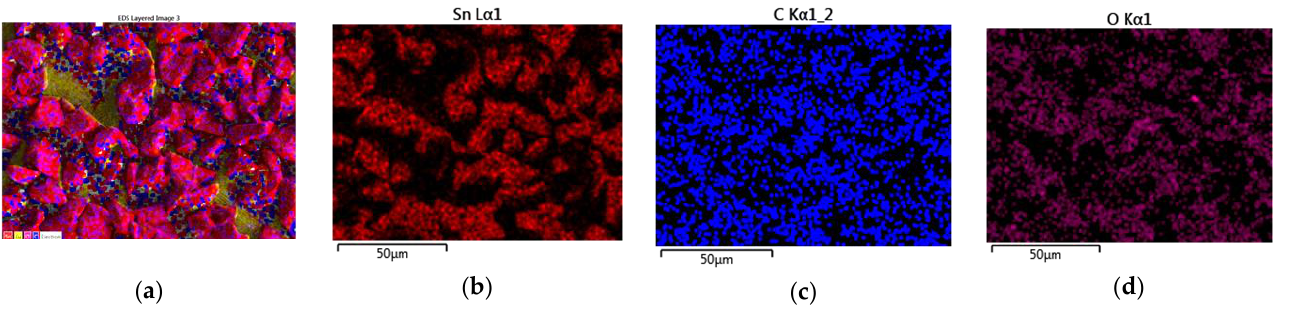
Figure 8. ( a ) EDX maps of elemental distribution for: Sn ( b ); C ( c ) and O ( d ) in the case of Sn-rGO composite coating electrodeposited from ILEG + 0.7 M SnCl 2 + 20 mg L − 1 GO at 25 mA cm − 2 ; temperature 70 °C, electric charge 18 C cm − 2 .